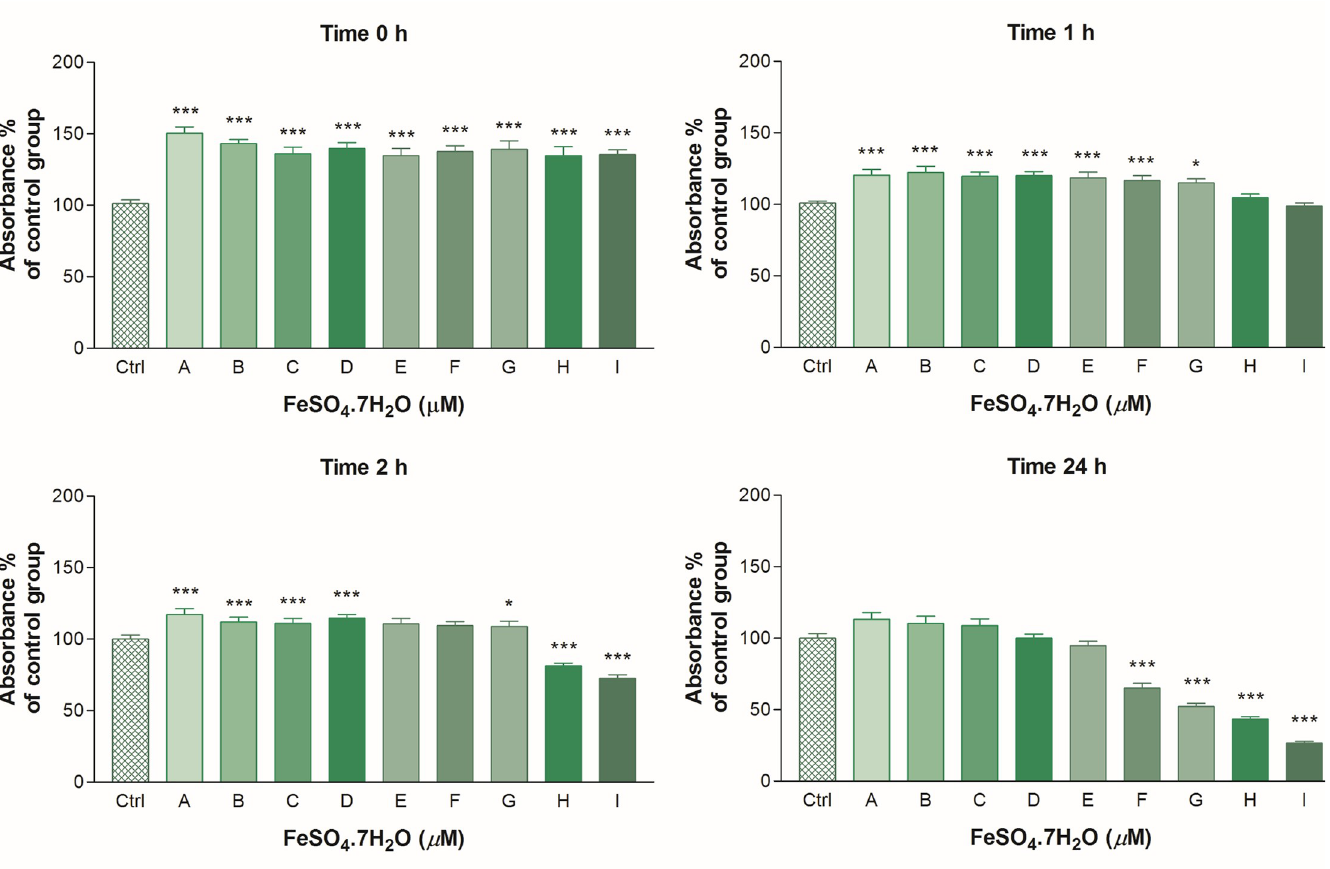
Fig 2. The effect of FeSO 4 .7H 2 O on the viability of spermatozoa in different time periods. Each bar represents the arithmetic mean ( ± SD) absorbance in % of (untreated) control group (Ctrl), which represented 100%. Results of the analysis were obtained of 7 independent experiments at each concentration. A decline in absorbance reflects a decline in the cell viability. The control group (Ctrl) received a culture medium without FeSO 4 .7H 2 O administration; Group A– 3.90 μ M; B– 7.80 μ M; C– 15.60 μ M; D– 31.20 μ M; E– 62.50 μ M; F– 125 μ M; G– 250 μ M; H– 500 μ M; I– 1000 μ M of FeSO 4 .7H 2 O. The statistical difference between the values of Ctrl and treated spermatozoa was indicated by asterisks ��� P < 0.001; �� P < 0.01; � P < 0.05 (One-way ANOVA with Dunnett’s multiple comparison test). MTT